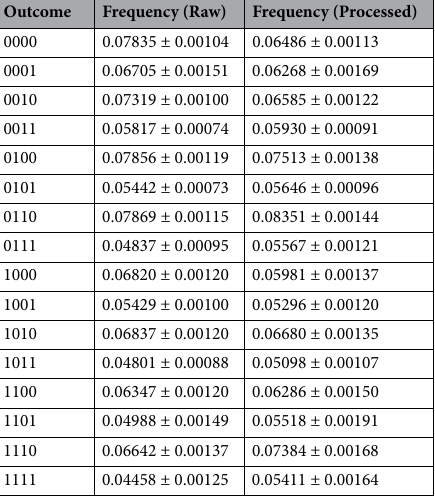
Outcome Frequency